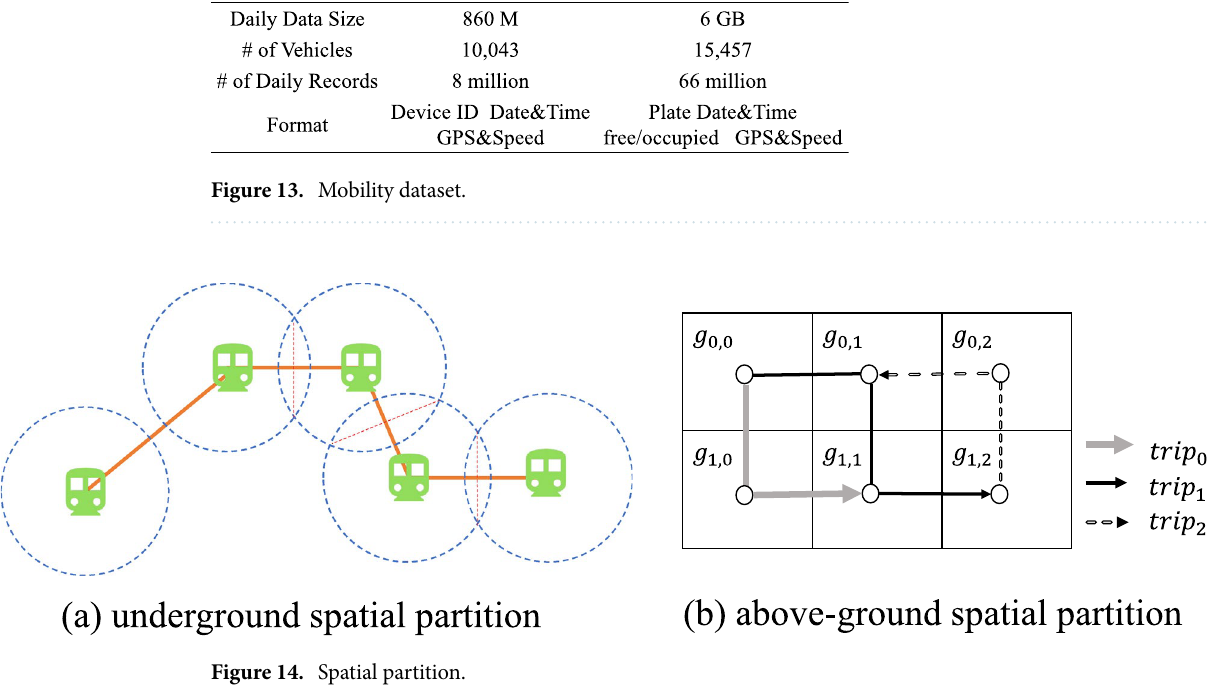
Figure 14. Spatial